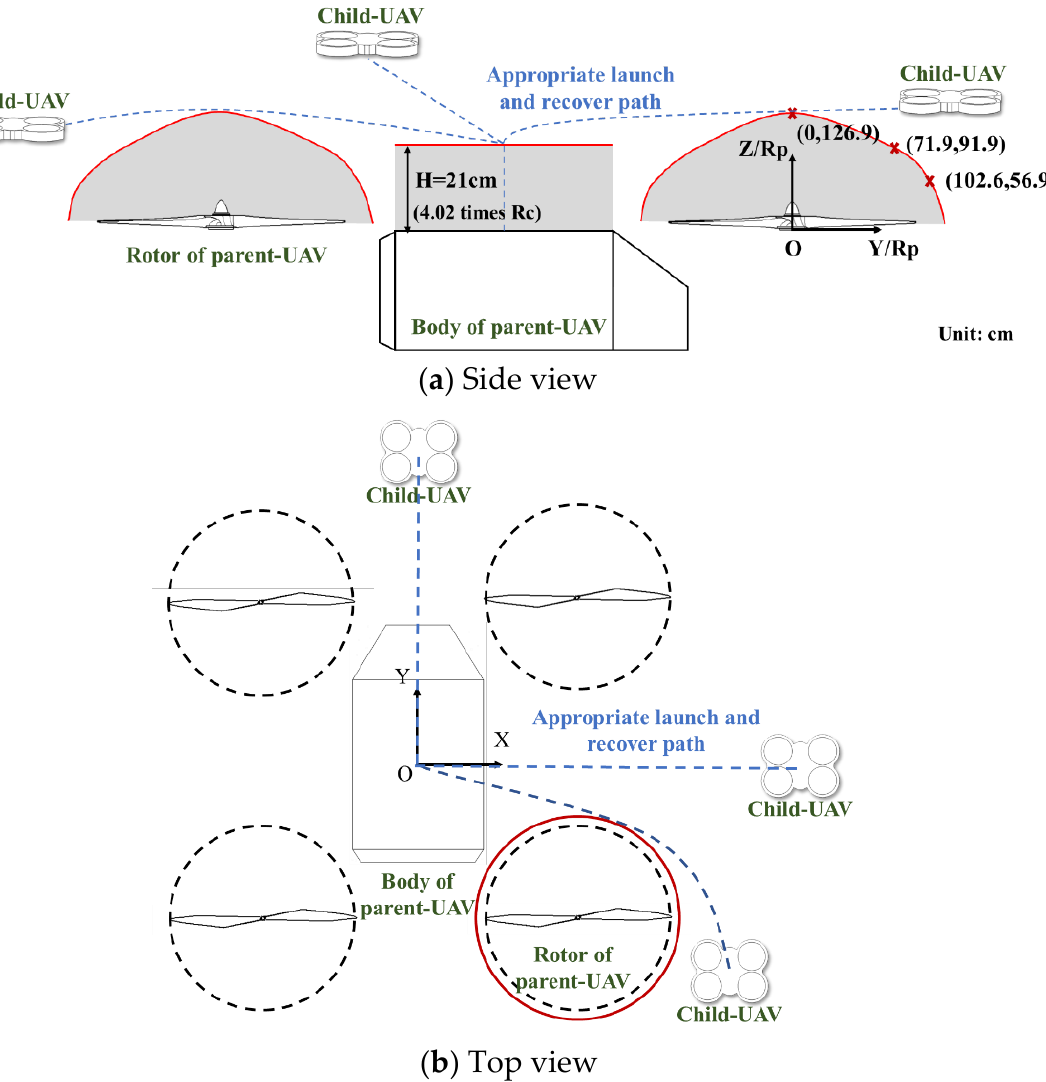
18 of 21 Figure 23. The flow filed of body-outside transition area.